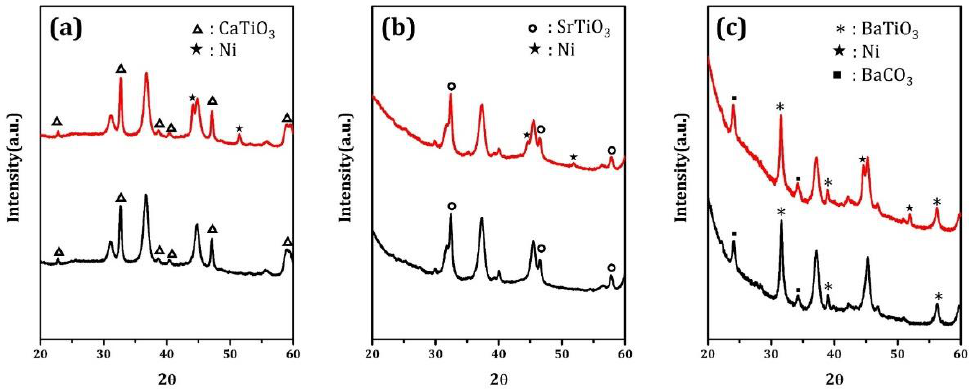
Figure 4. X-ray di ff raction (XRD) patterns for ( a ) Ni / CaTiO 3 / MgAl 2 O 4 , ( b ) Ni / SrTiO 3 / MgAl 2 O 4 , ( c ) Ni / BaTiO 3 / MgAl 2 O 4 after (black) 1073 K oxidation followed by 773 K reduction and (red) 1073 K oxidation followed by 1073 K reduction.